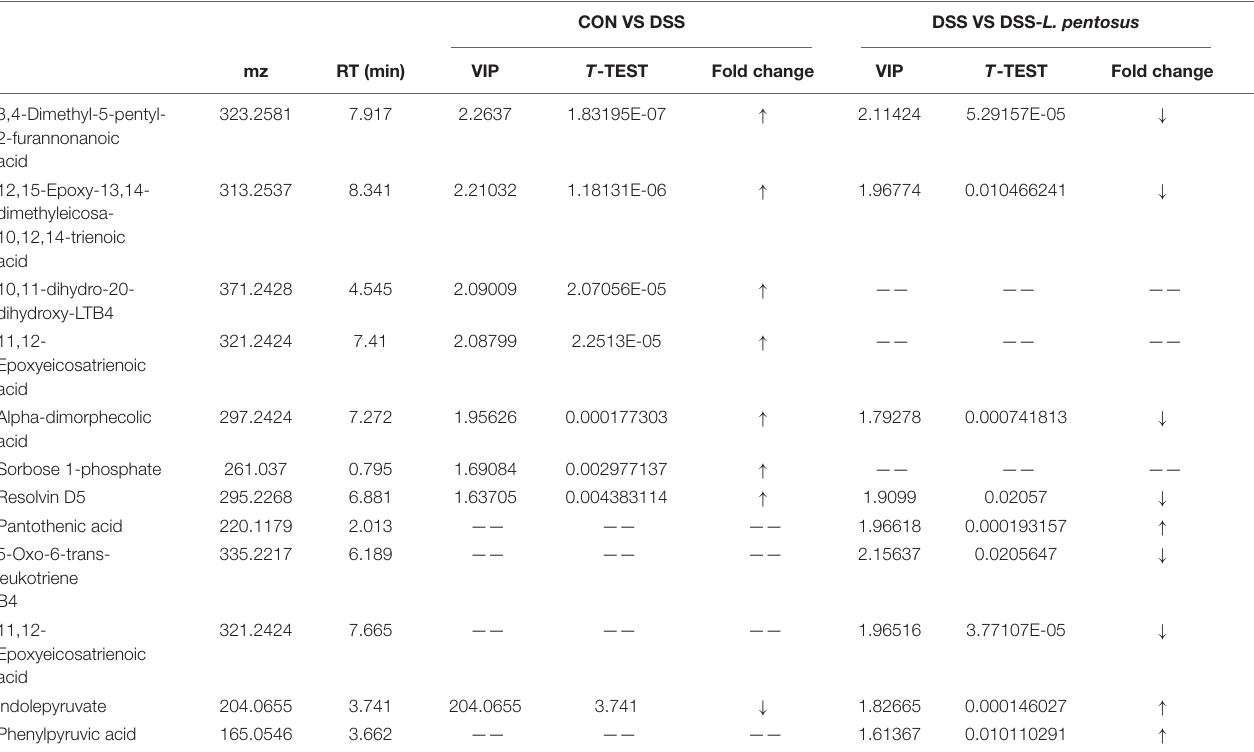
mz RT (min) VIP T -TEST Fold change VIP T -TEST Fold